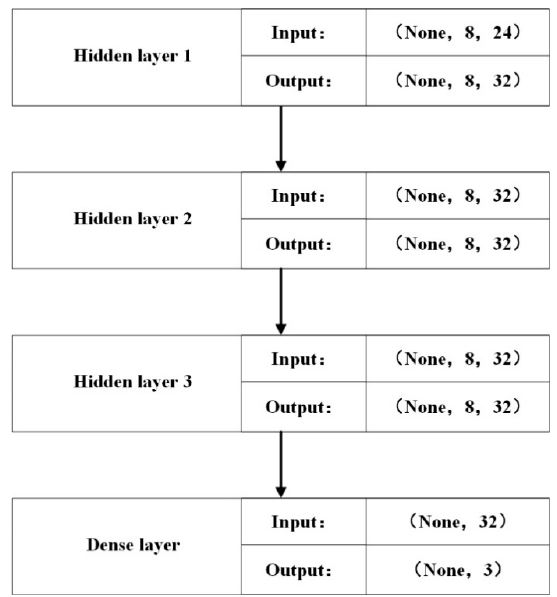
Figure 5. RNN model structure.